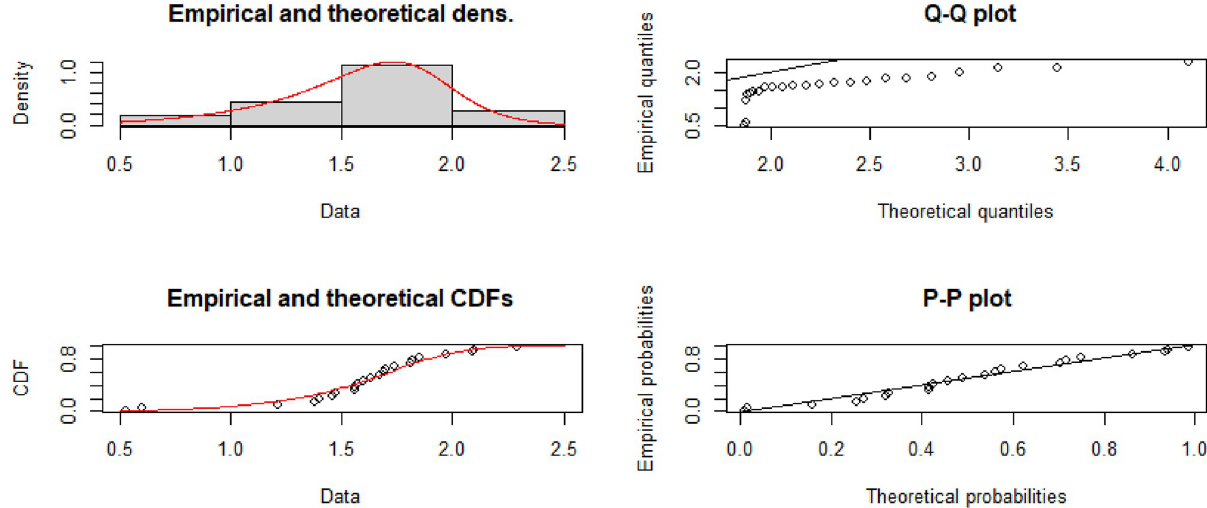
Fig 11. Fitted pdf, cdf, qq and pp plots of the hcMB − III distribution for eye data.